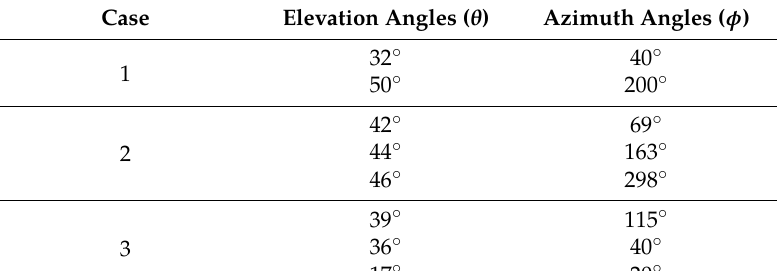
Table 5. Directions of arrival signals.